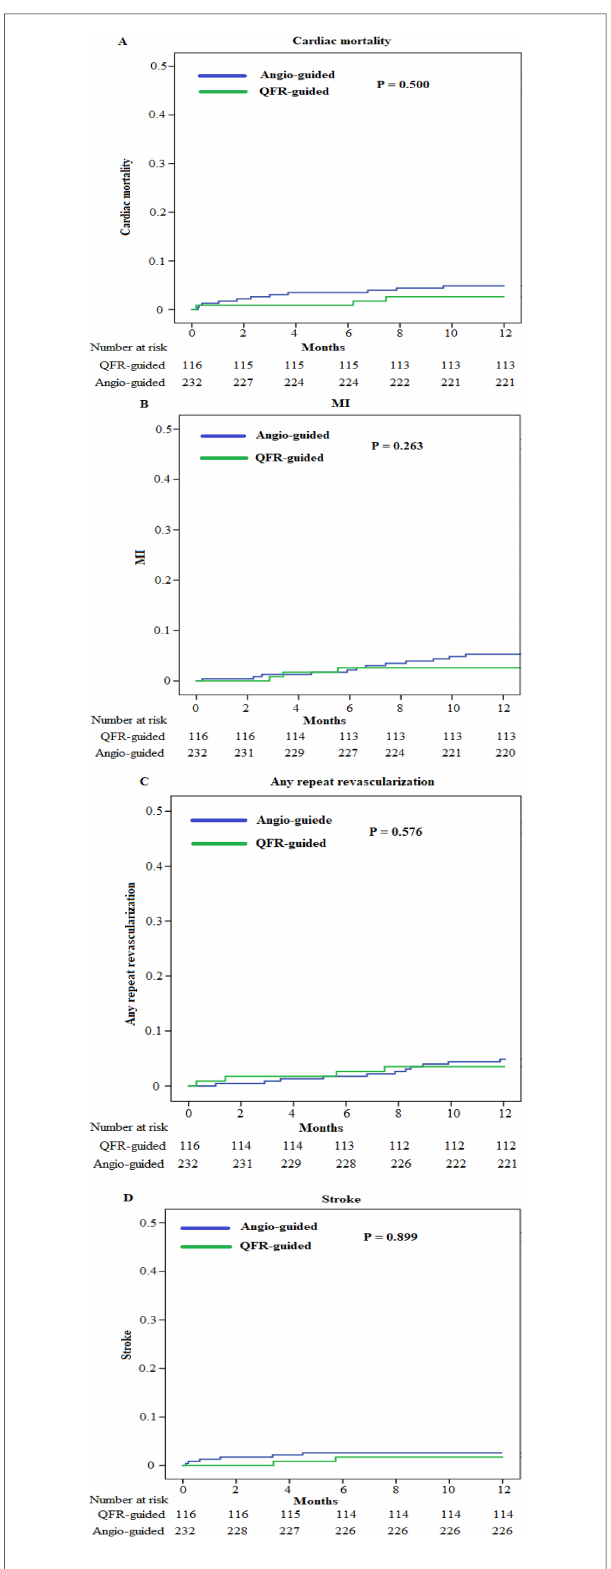
FIGURE 4 Kaplan – Meier curves for the secondary endpoints. ( A ) Kaplan – Meier curves for cardiac mortality. ( B ) Kaplan – Meier curves for MI. ( C ) Kaplan – Meier curves for any repeat revascularization. ( D ) Kaplan – Meier curves for